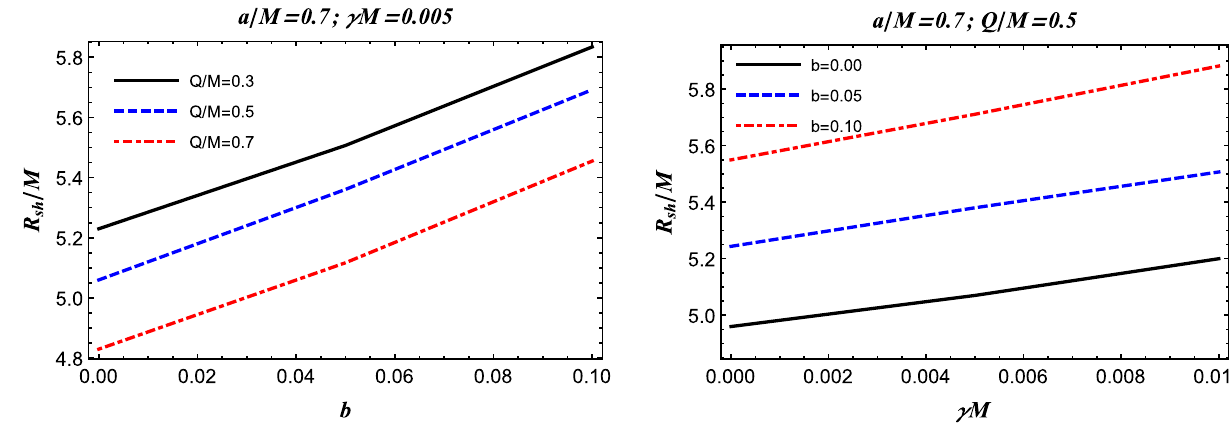
Fig. 4 Plots show the dependence of the radius of the black hole shadow on the different spacetime parameters